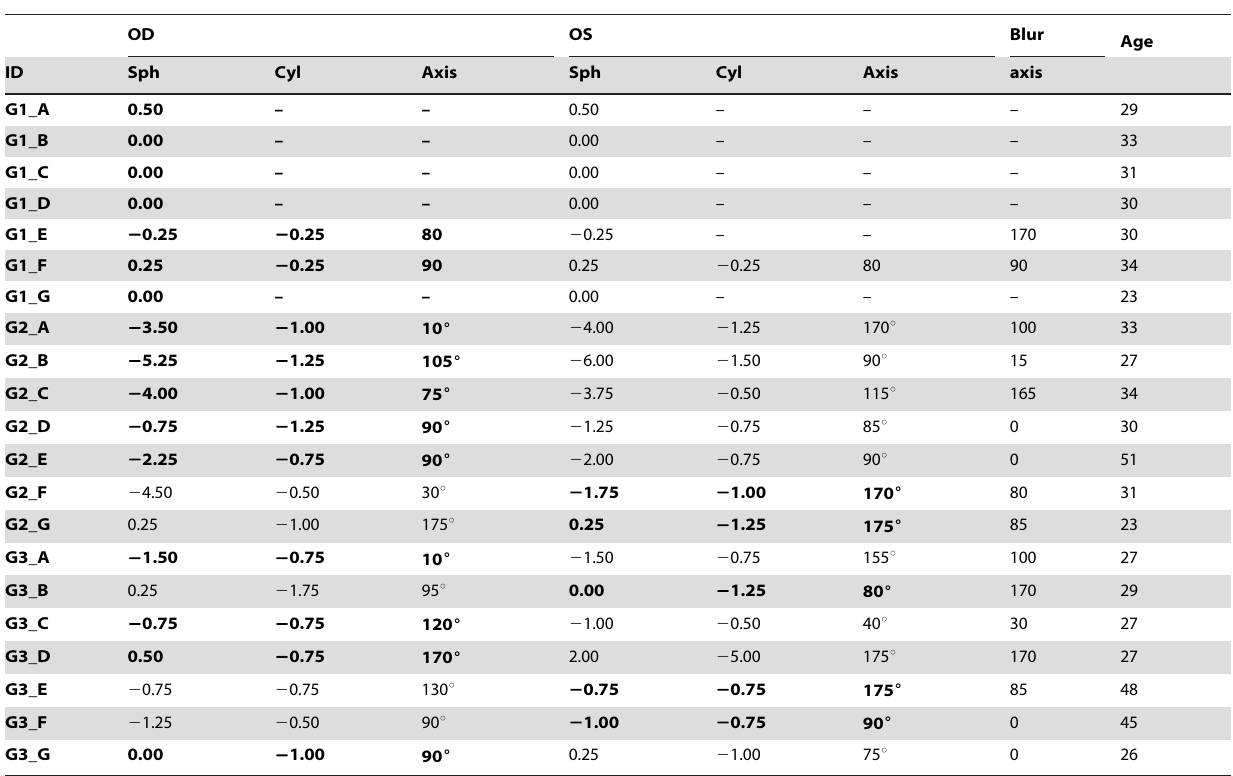
Table 1. Subjects’